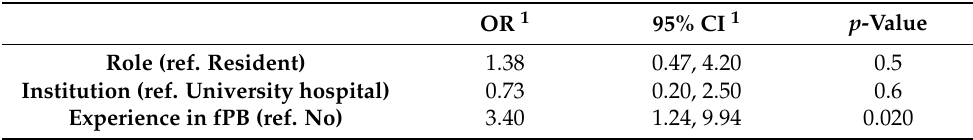
Table 2. Multivariable logistic regression model testing possible predictors of proficiency in mpMRI